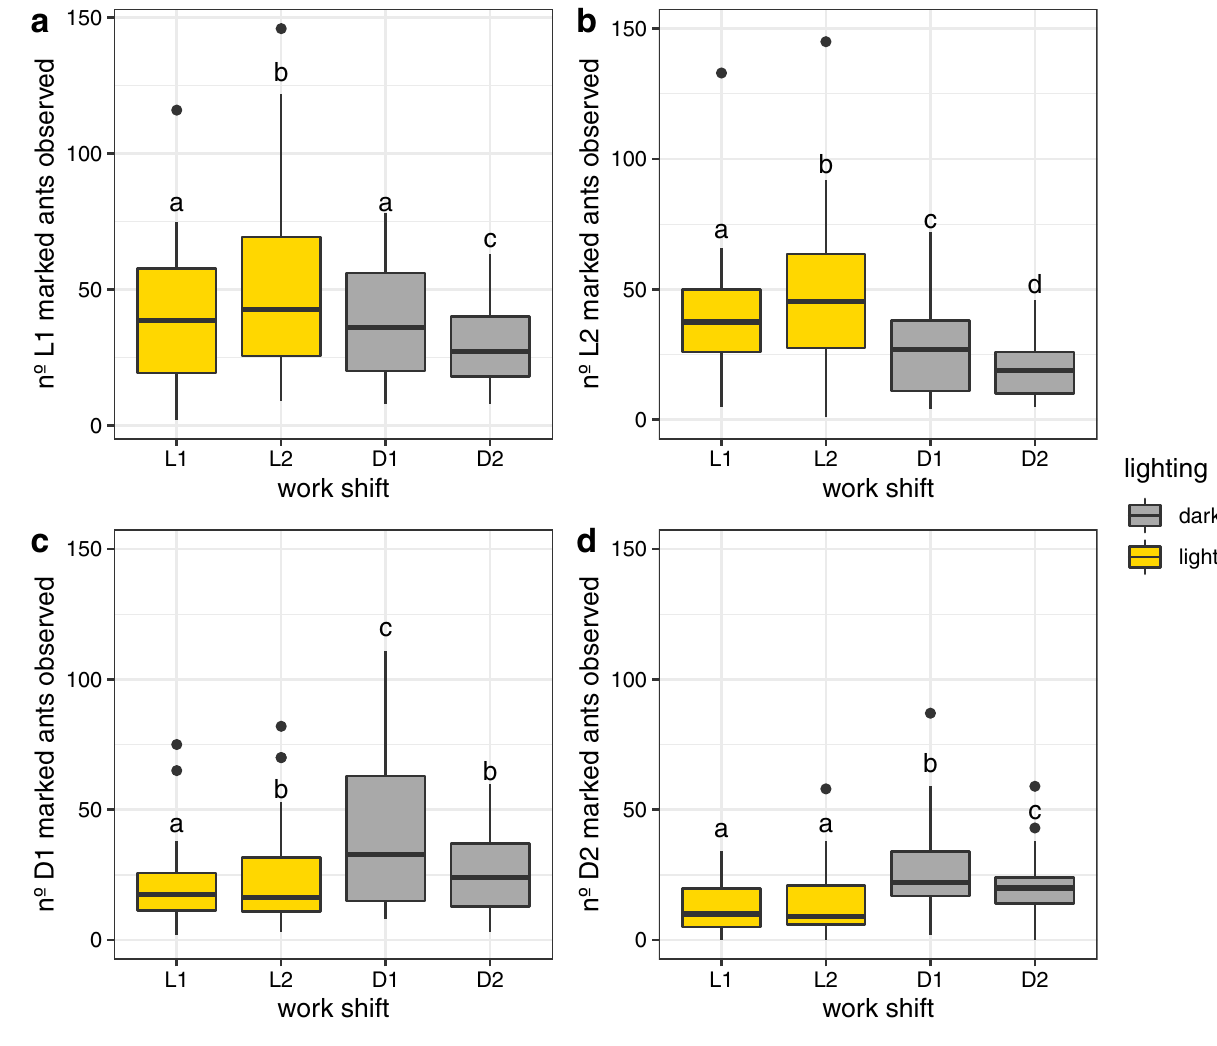
Figure 3. Distribution of marked ants in each work shift for the 5 observation days. Boxplots represents the distribution of marked ants observed for the 5 day period and for the 6 colonies analyzed. (a) Ants marked on L1 tended to forage at L2 work shift; (b) ants marked on L2 tended to forage at L2 work shift; (c) ants marked on D1 tended to forage at D1 work shift; (d) ants marked on D2 tended to forage at D1 work shift. Letters above boxplots indicate statistically different distributions using Tukey method for comparing a family of 4